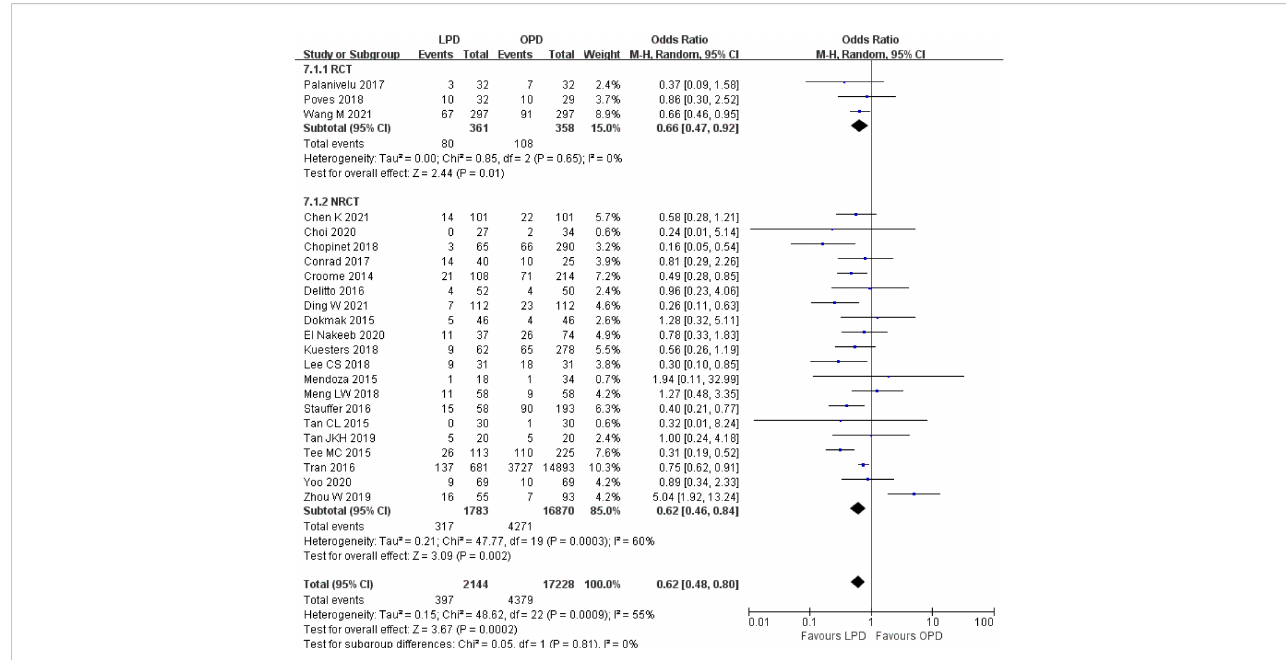
FIGURE 7 Forest plot of comparison between LPD and OPD on intraoperative blood transfusion. LPD, laparoscopic pancreaticoduodenectom; OPD, open pancreaticoduodenectomy.